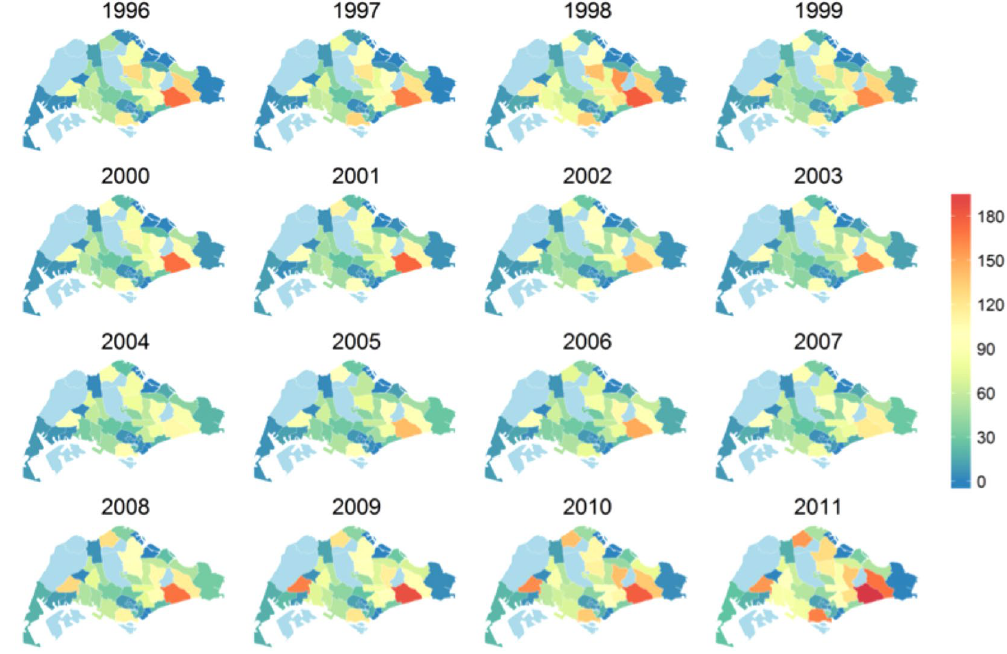
Figure 2. Estimated case count of TB cases in 44 planning areas of Singapore. Counts were computed by integrating the estimated spatial intensity over the planning area polygons. The plots capture higher risk of cases in Bedok and the surge of cases in Jurong West. Plots were created in statistical program R 22 using the package spatstat 19 . Administrative and national political coordinates of Singapore were provided, for academic research and publication, by the Singapore Land Authority (SLA) 24